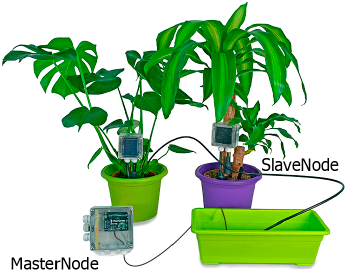
Figure 2. Architecture sensor network.